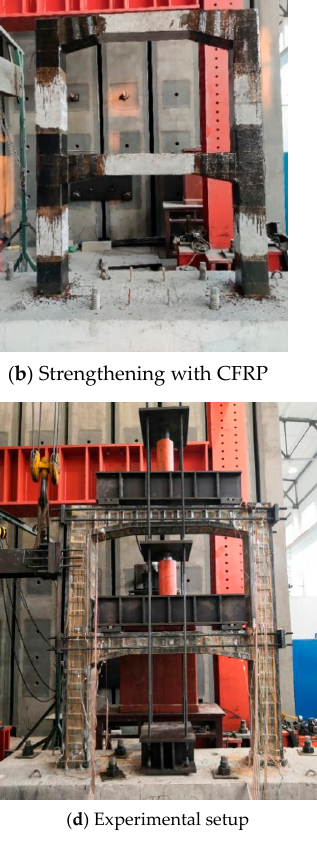
Figure 6. On-site photographs.